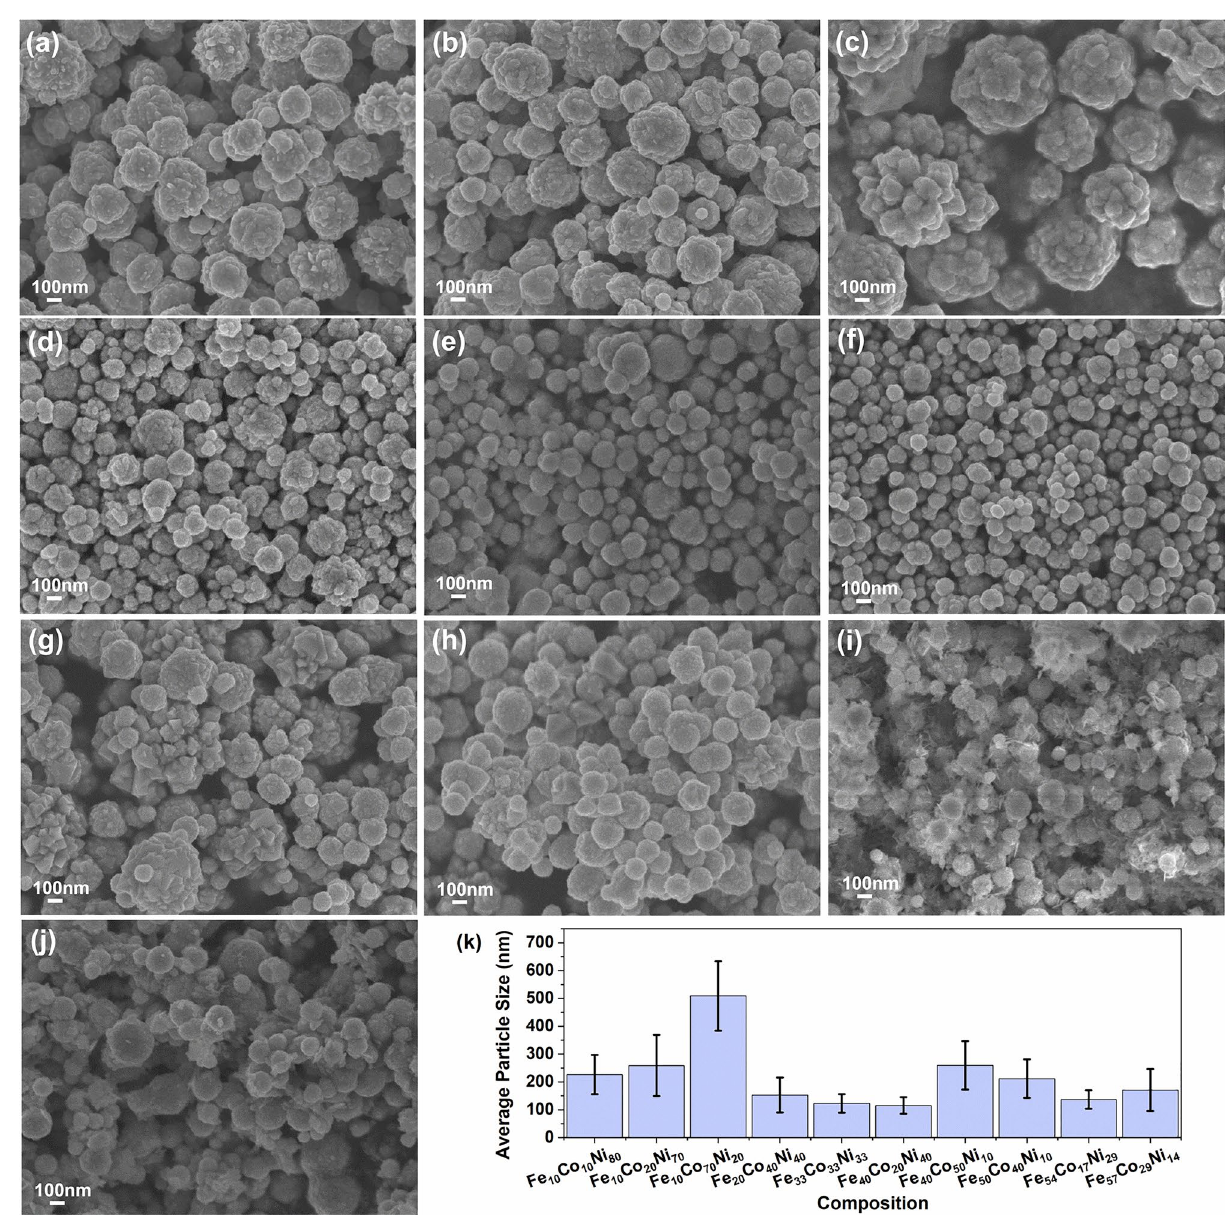
Figure 2. Size and morphology of the synthesized ternary alloy powders: ( a ) Fe 10 Co 10 Ni 80 , ( b ) Fe 10 Co 20 Ni 70 , ( c )